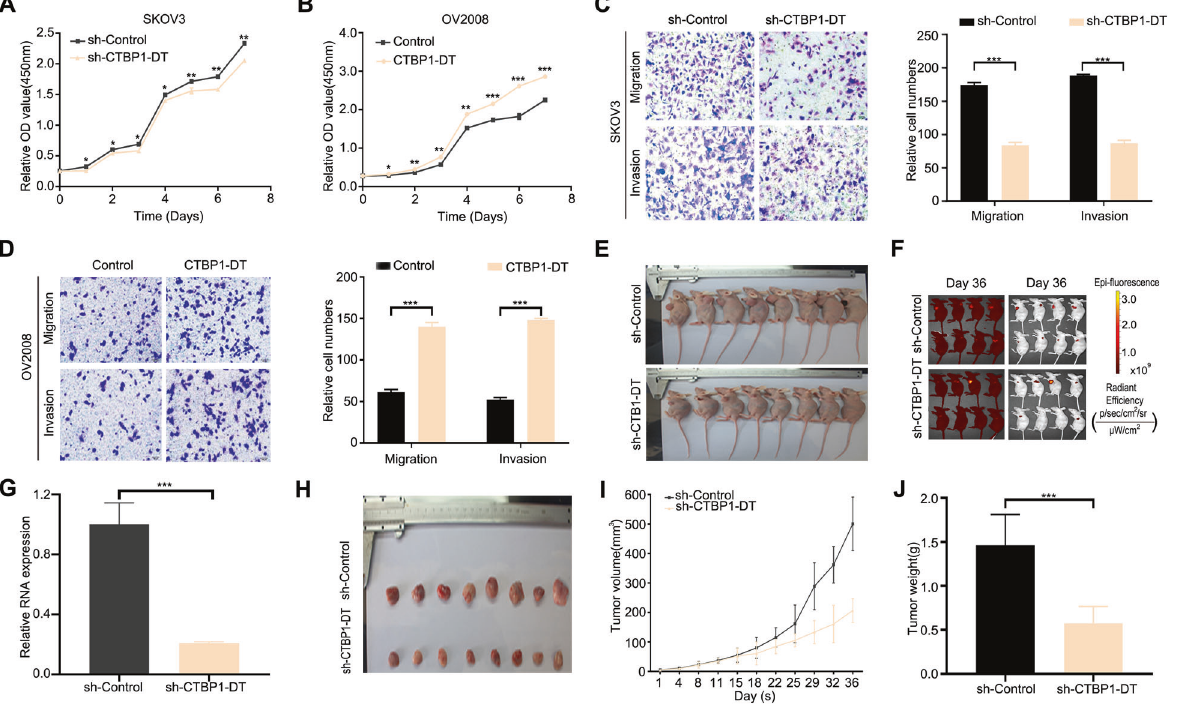
Fig. 2 LncRNA CTBP1-DT promotes HGSOC cell proliferation, migration and invasion in vivo and in vitro. A , B CCK-8 assays were performed to determine the proliferation ability of SKOV3 cells transfected with sh-lncRNA CTBP1-DT or NC and OV2008 cells transfected with lncRNA CTBP1-DT or vector. C , D Transwell assays were performed in SKOV3 cells transfected with sh-lncRNA CTBP1-DT or control and OV2008 cells transfected with lncRNA CTBP1-DT or vector to explore cell migratory and invasive capabilities. E Image of mice in the lncRNA CTBP1-DT- knockdown and control groups. F Image of mice in the lncRNA CTBP1-DT-knockdown and control groups by in vivo optical imaging with bioluminescence and fl uorescence at day 36. G qRT-PCR was applied to determine lncRNA CTBP1-DT expression in tissues derived from the xenograft tumour model. H Image of subcutaneous tumour tissues in the lncRNA CTBP1-DT-overexpression group and control group. I Analysis of tumour volume of mice. J The relative weights of mice tumours were measured. Data are reported as mean ± SEM. * P < 0.05, ** P < 0.01, *** P < 0.001.